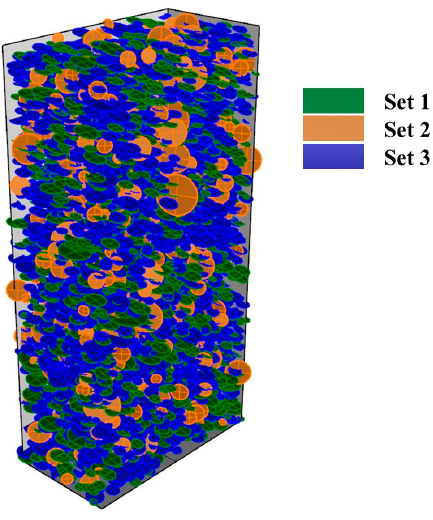
Figure 6. Final 3D fracture network model.